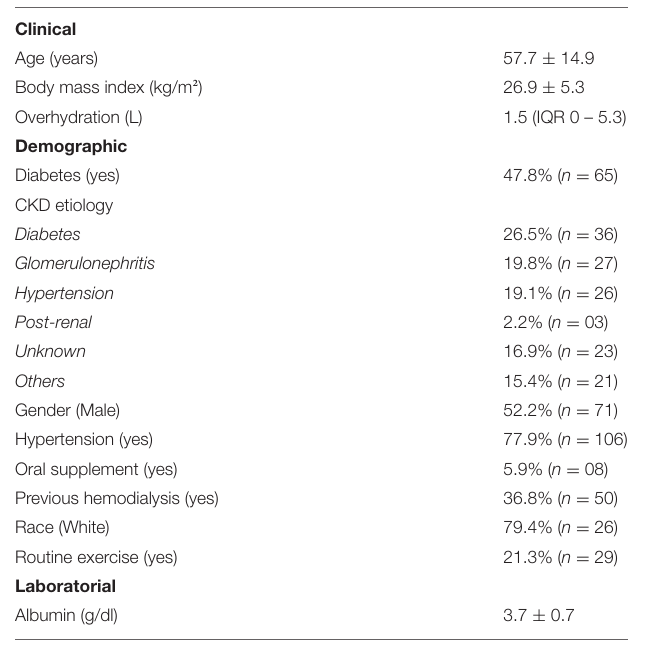
TABLE 1 | General characteristics of the study population.